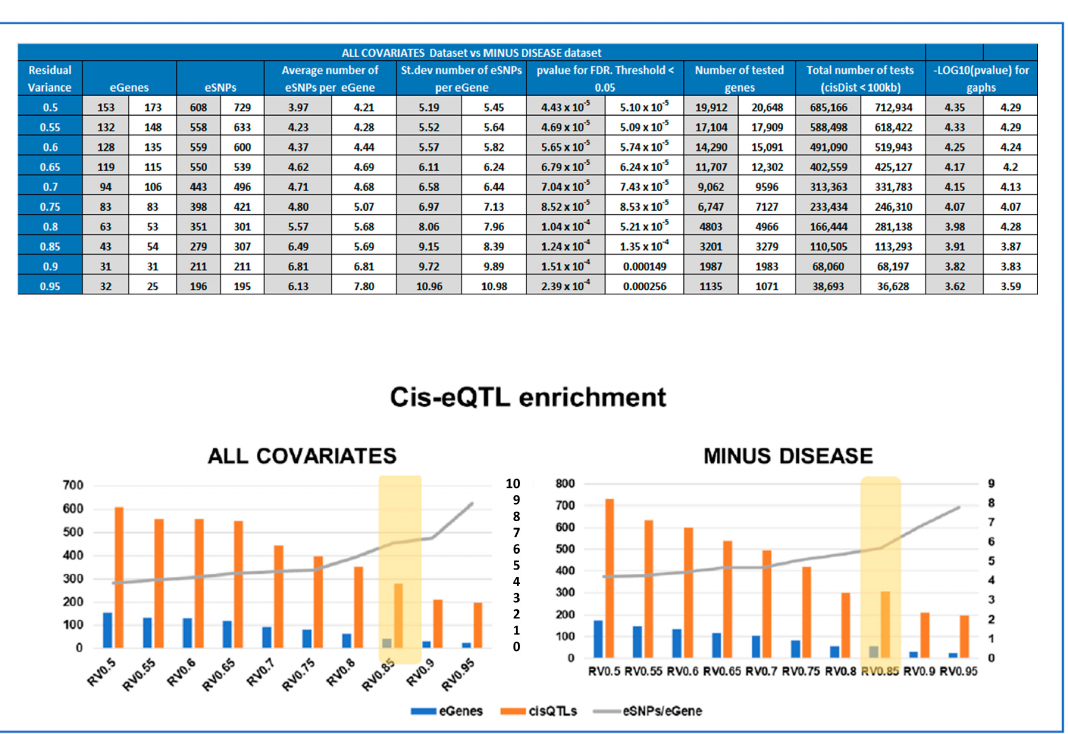
Figure 4. Comparing the experimental parameters for the ALL COVARIATES and MINUS DISEASE eQTL datasets. ( TOP ) Table comparing the parameters of cis-eQTL analyses performed for different Residual Variance (RV) thresholds (0.5-0.95) for ALL COVARIATES and MINUS DISEASE datasets. Depending on the RV threshold, different lists of genes were included in the cisQTL analysis, resulting in 10 output cis-QTL datasets for each approach, ALL COVARIATES in grey and MINUS DISEASE in white. ( BOTTOM ) Cis-eQTL enrichment graphs for each approach at the different thresholds of residual variance tested. Showing the number of significant eGenes (blue), eSNP (orange), and enrichment expressed as number of eSNP/eGene in